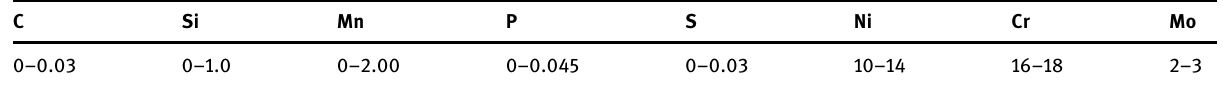
Table 1: Chemical compositions of 316 L stainless steel powders ( wt% )